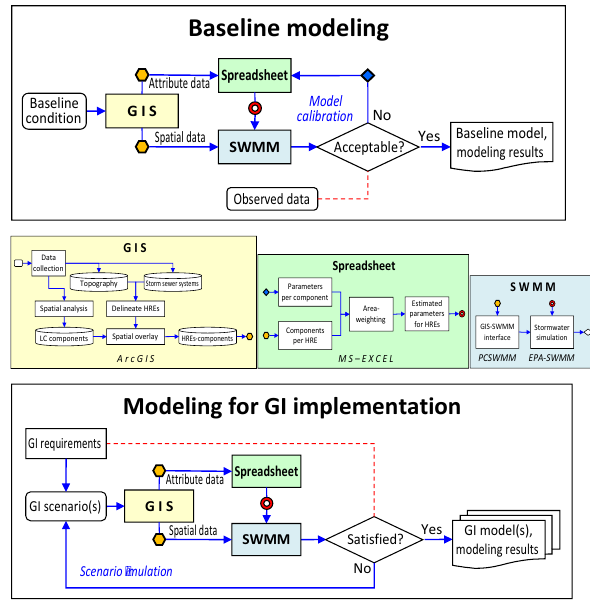
Figure A1. Procedures for SWMM modeling for GI analysis. LC stands for land cover. Conceptual workflow for each of the colored boxes is given in the middle of the diagram. Symbols ( ) are used to label workflow connections within the colored boxes. Top panel depicts the general steps used for baseline model setup, while the bottom panel adds GI considerations. “Acceptable?” indi- cates whether the statistical significance between the modeled and the observed hydrographs (e.g., Nash–Sutcliffe coefficient or R 2 ) is acceptable. “Satisfied?” indicates whether the modeling results are satisfied with the GI